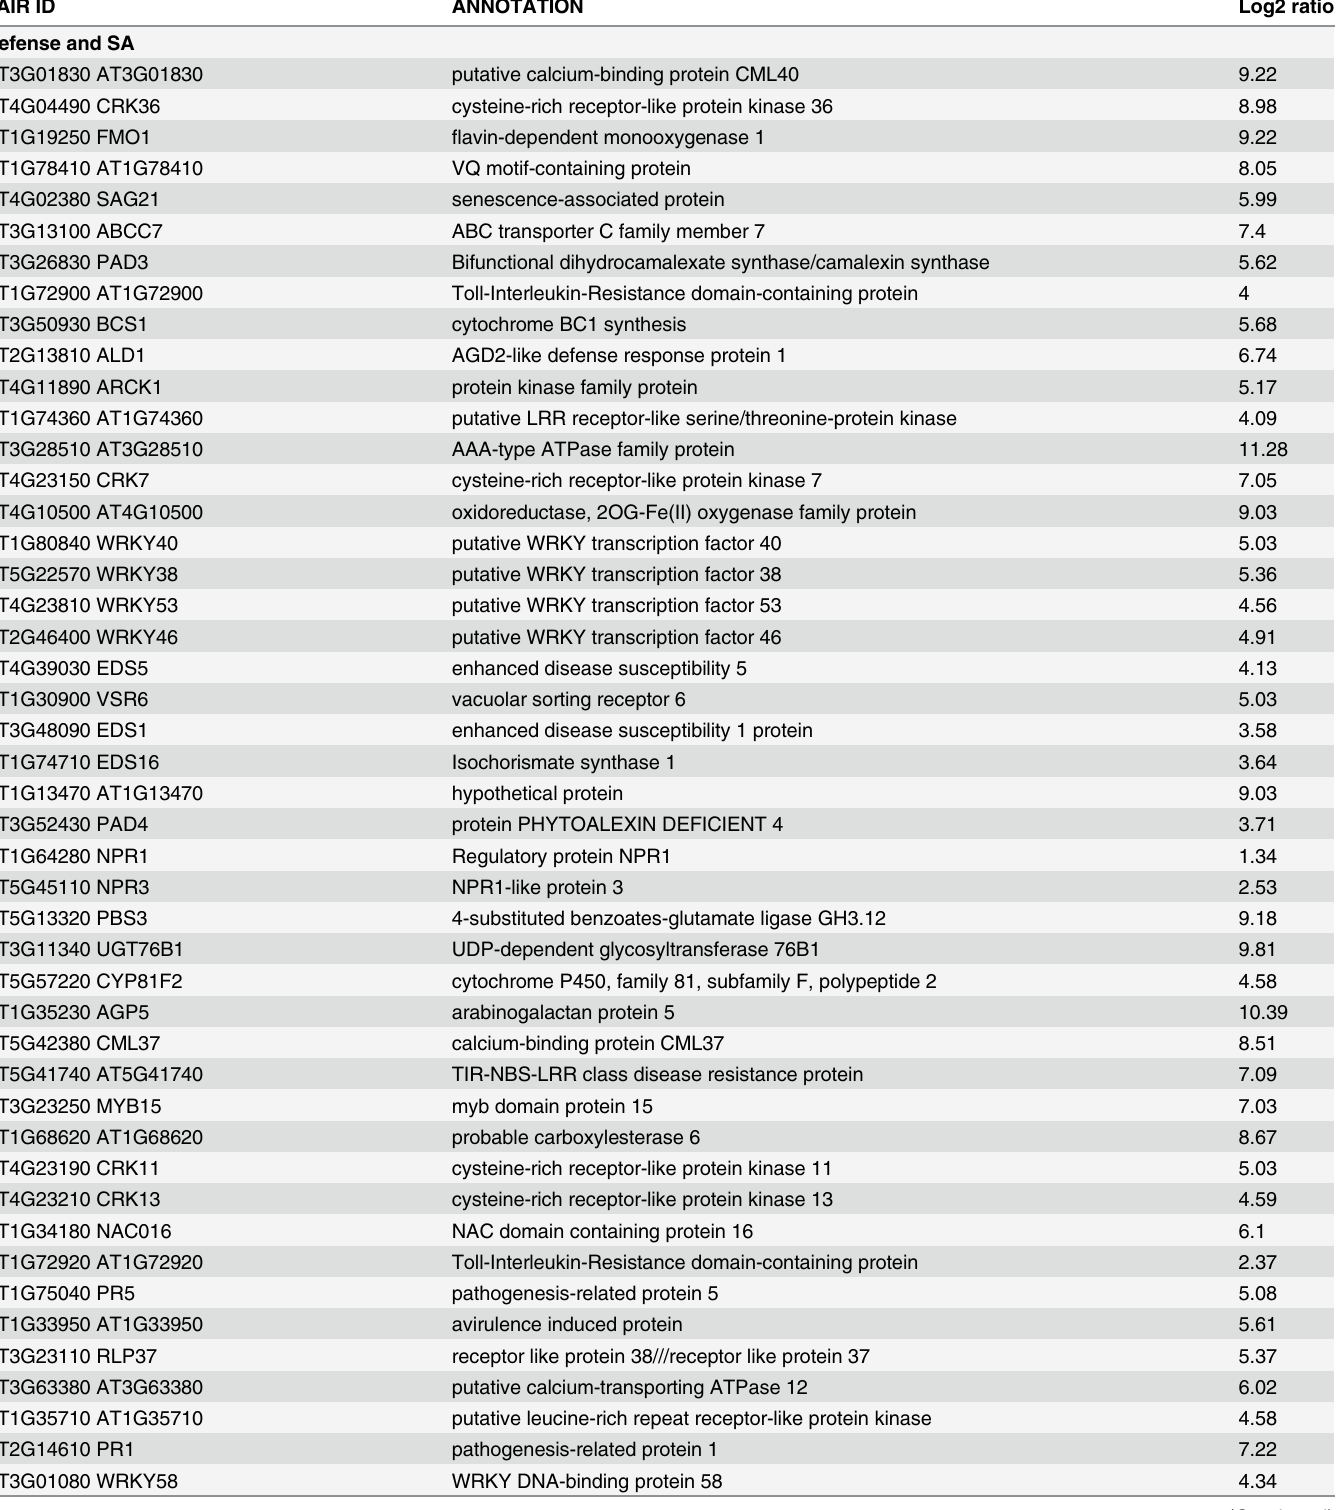
Table 1. The cluster of selected high expression genes in microarray data at 24 h after PPA treatment. TAIR